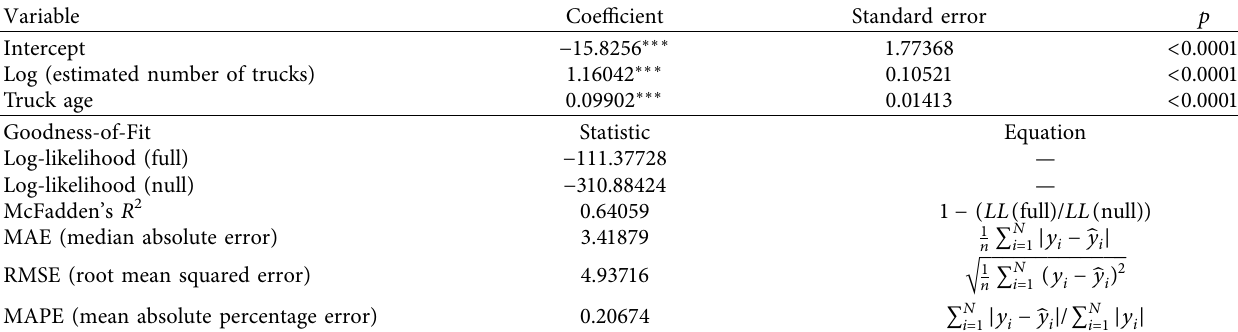
Table 6: Poisson model for truck crashes occurring due to mechanical failure by truck age ( N �